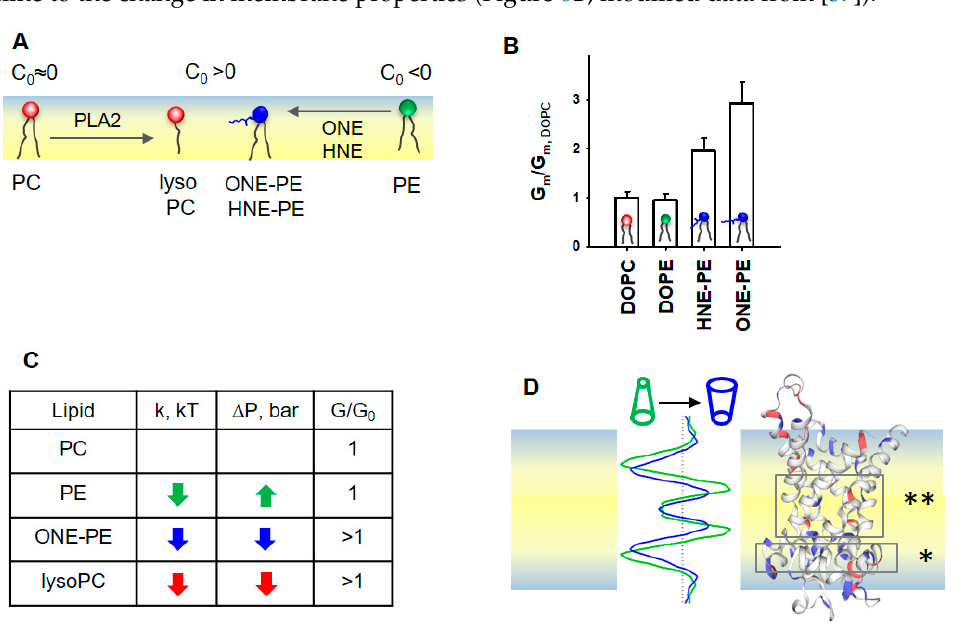
Figure 6. Proposed mechanism for the SCES sensing by mitochondrial proteins ANT1 and UCP1. ( A ) Schematic representation of the lipid membrane leaflet and change in lipid shapes under oxidative stress in mitochondria. ( B ) Effect of PE adducts, ONE-PE and HNE-PE, on the UCP1-mediated G m in the presence of AA . The relative membrane conductance G m /G m,DOPC was calculated based on data from [37]. G m,DOPC , and G m are specific membrane conductance in the absence or presence of PE or RA-PEs, respectively. ( C ) Schematic representation of the LPP redistribution in the lipid bilayer membrane caused by a change in the lipid shape. A comparison of the LPP (left) and protein structure (right) suggests that the decreased lateral pressure (dark blue), which appeared in the area of the FA binding site (*) and in the protein cavity region (**), promotes FA translocation. Most likely, the transformed lipid environment (i) increases the probability that anionic FA reaches a protein binding site and (ii) facilitates a protein conformational change, which in turn supports a faster translocation of FA to the opposite leaflet. ( D ) The increase in the UCP1- and ANT1- mediated G m correlates with a decrease in both the lateral pressure, p, and bending rigidity, k , in the lipid bilayer membrane. If the change in p and k goes in the opposite direction, the protein-mediated G m is not affected, as demonstrated here for the DOPE-containing membrane.